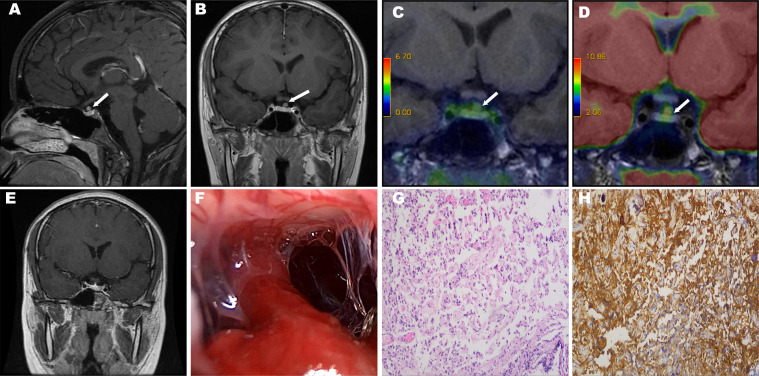
The white arrows show the ectopic tumors. MRI revealed a mass superior of the pituitary gland (A, B). PET/MRI: Two markers revealed different degrees of enhancement in the suprasellar region overlapping at the tumor site. Octreotide imaging labeled with 68Ga (C). 18F-fluorodeoxyglucose imaging (D). Postoperative MRI revealed that the tumor was completely removed (E). Intraoperative photographs showed the pituitary stalk and sellar diaphragm are intact after tumor resection (F). Histological examination of resected tumor tissue (×100). Hematoxylin-eosin staining reveals pituitary adenoma (G). Immunohistochemical staining shows a positive reaction for thyrotropin (H).